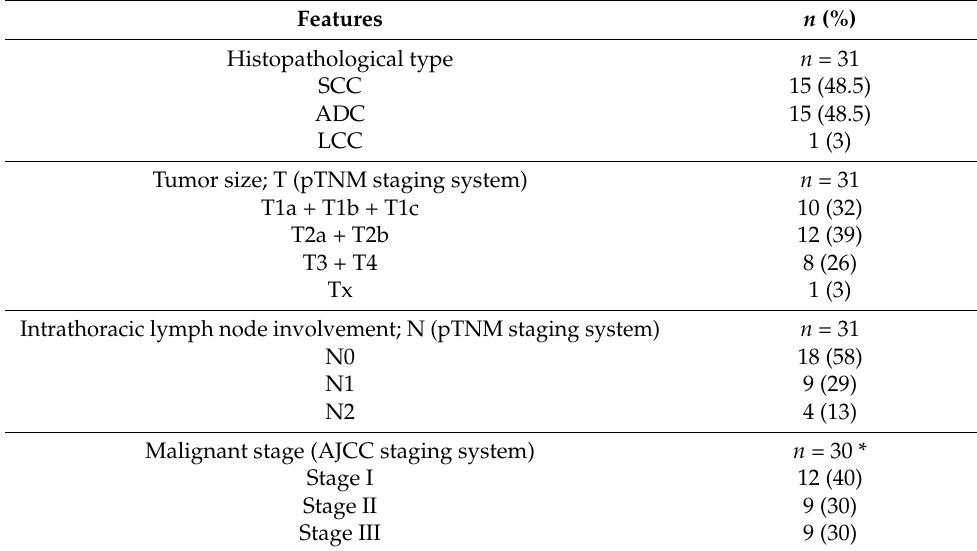
Table 1. Histopathological features of NSCLC